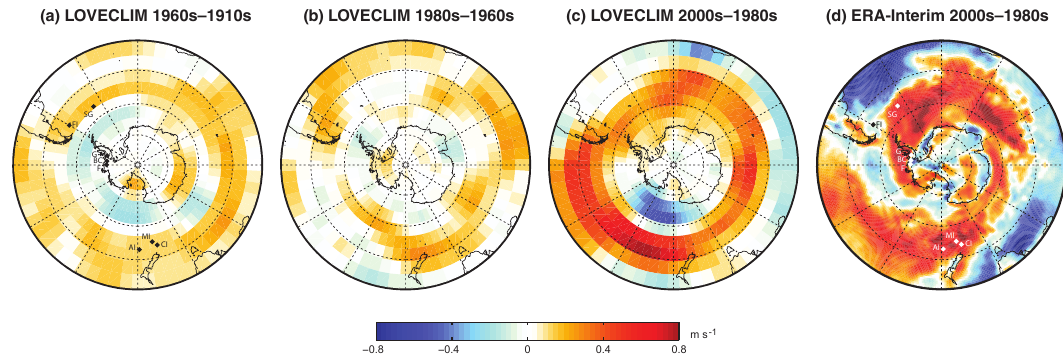
Figure 8. Modelled changes in Southern Hemisphere westerly airflow over the last century. Differences in zonal October–March wind speed (ms − 1 ) at 800hPa across the Southern Ocean derived from LOVECLIM1.3 (Zunz and Goosse, 2015) (a–c) and ERA-Interim (Dee et al., 2011) (d) . Locations of key sites discussed in the text are also